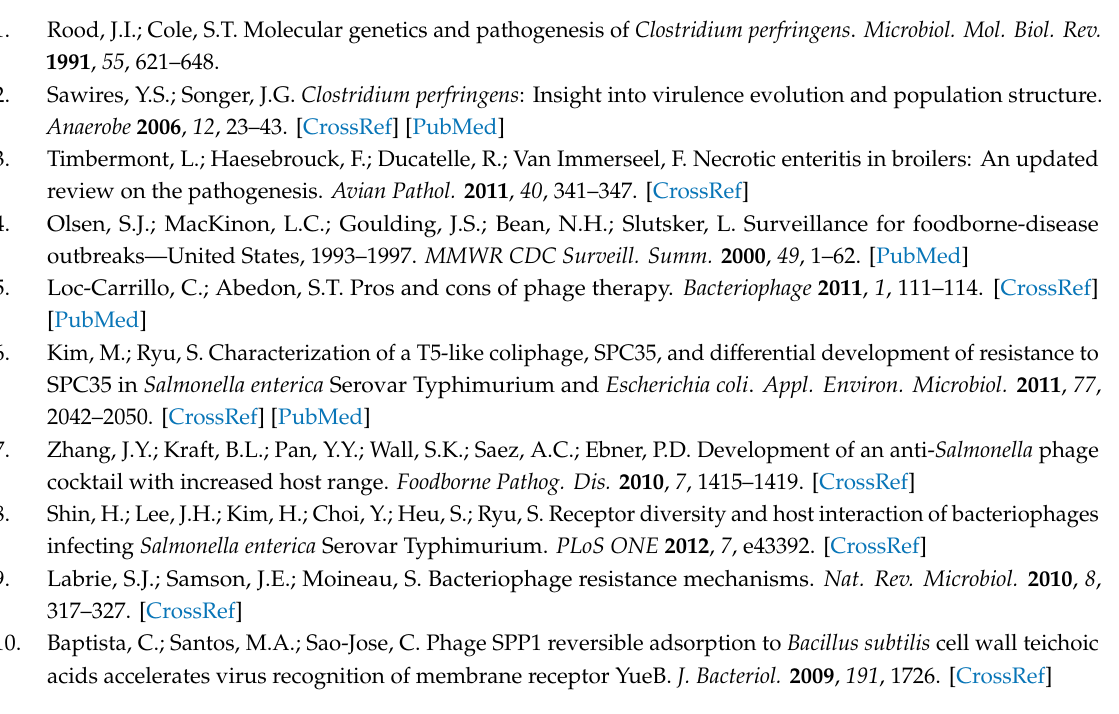
Figure S1: Optimization of C. perfringens ATCC 13124 electroporation conditions, Table S1: Primers used in this study, Table S2: Bacterial strains and plasmids used in this study, Table S3: Host range of phage